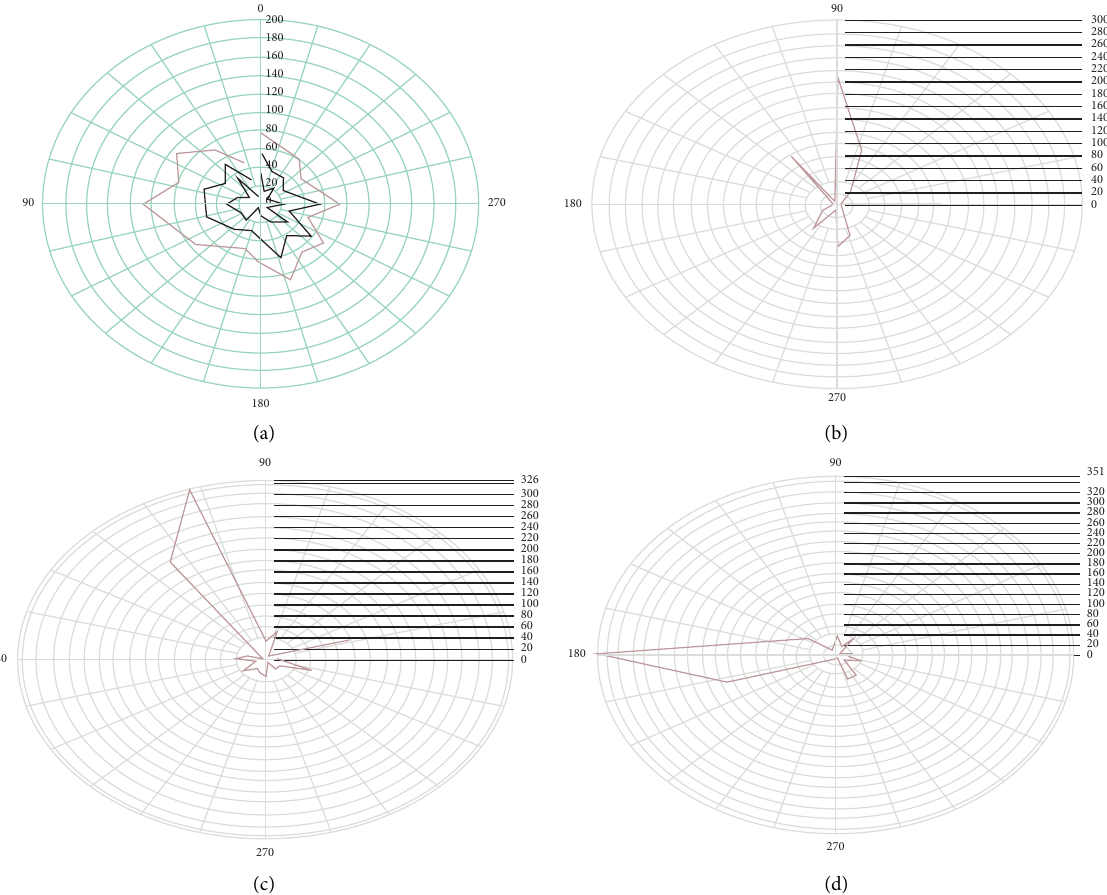
Figure 10: Polar plots of FFT peaks received by the radar: (a) during calibration phase, (b) with target-UAS hovering at 150m East (90 ° ), (c) at 150m Northeast (107 ° ), and (d) at 150m North (180 ° ).